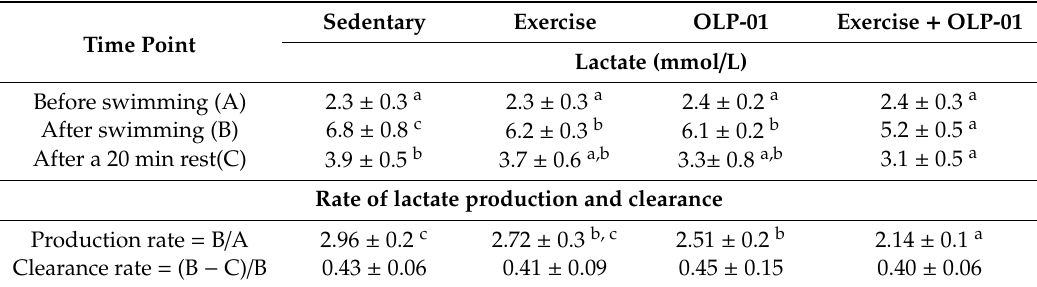
The e ff ects of exercise and probiotics on lactate metabolite profiles during acute Table 2. The effects of exercise and probiotics on lactate metabolite profiles during acute exercise exercise challenge.